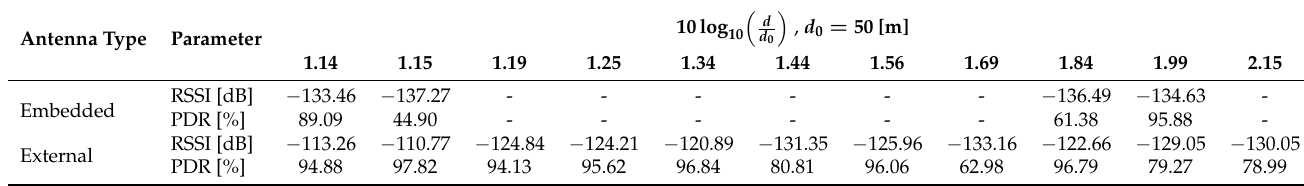
Table 5. Measured average of received power and Packet Delivery Ratio for Non-Line-of-Sight scenario (two turns).